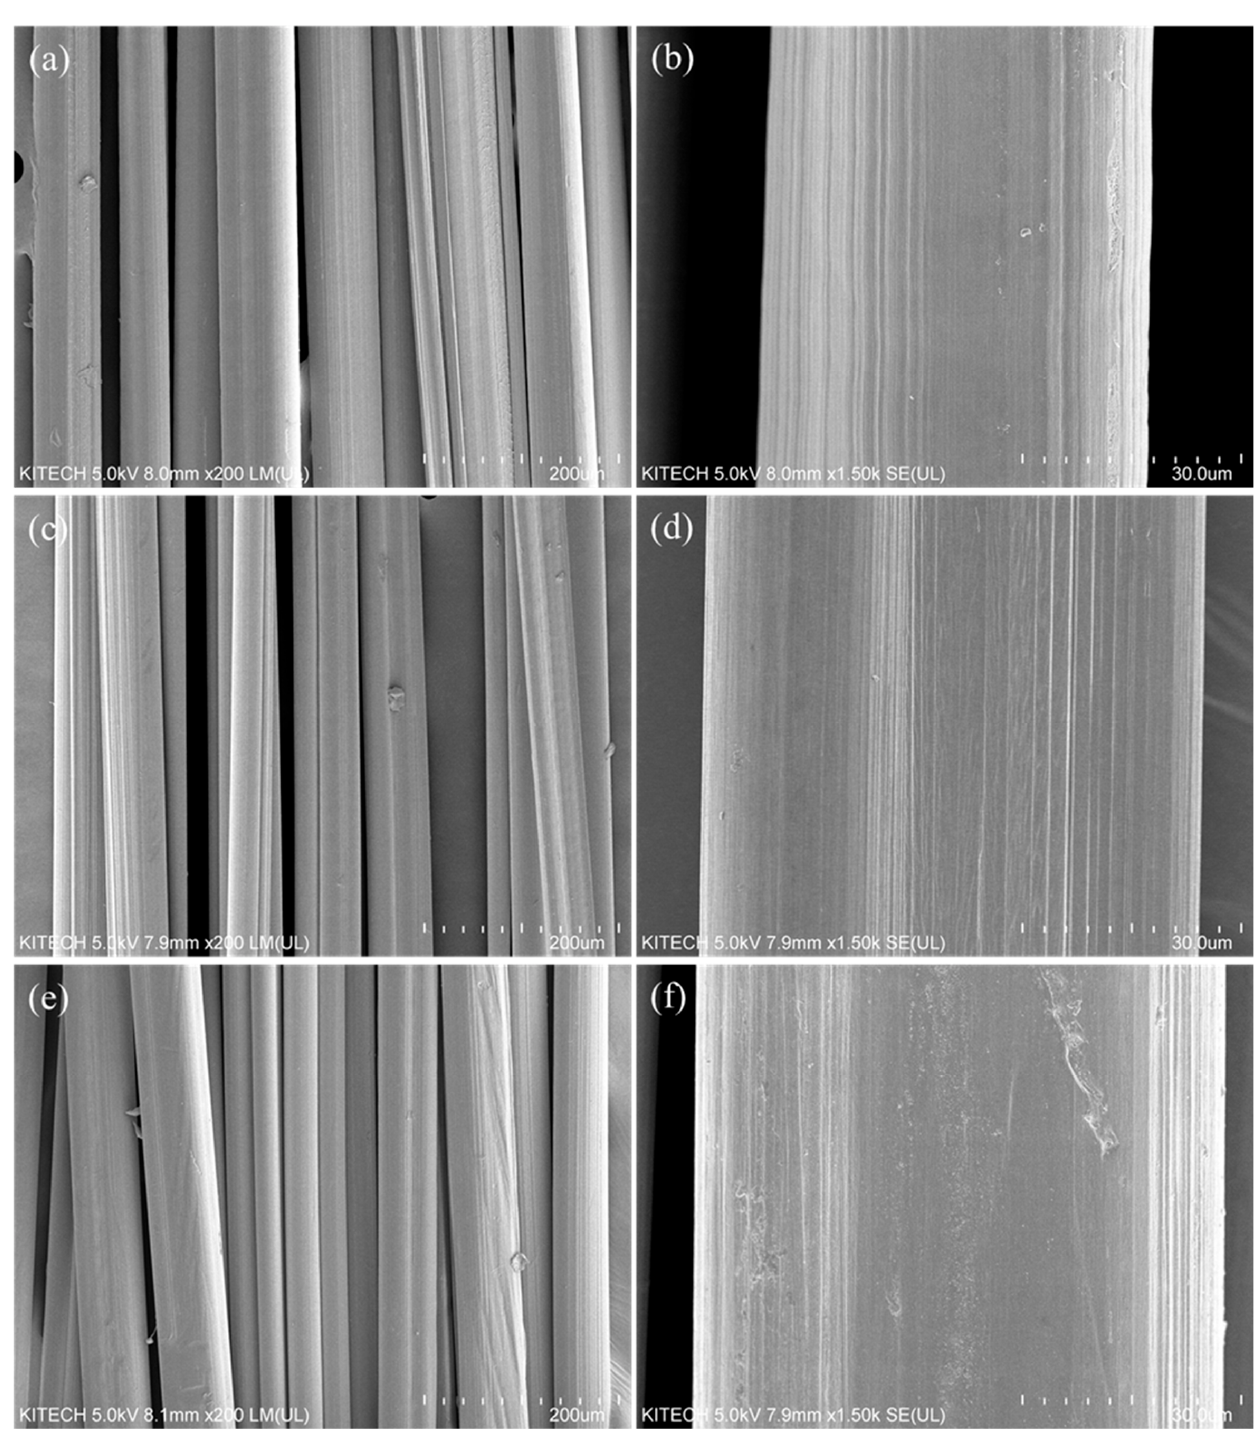
Figure 4. Scanning electron microscopy (SEM) images of as-spun P (AN-MA) precursor fibers; ( a , b ) LPAN, ( c , d ) MPAN, and ( e , f ) HPAN.